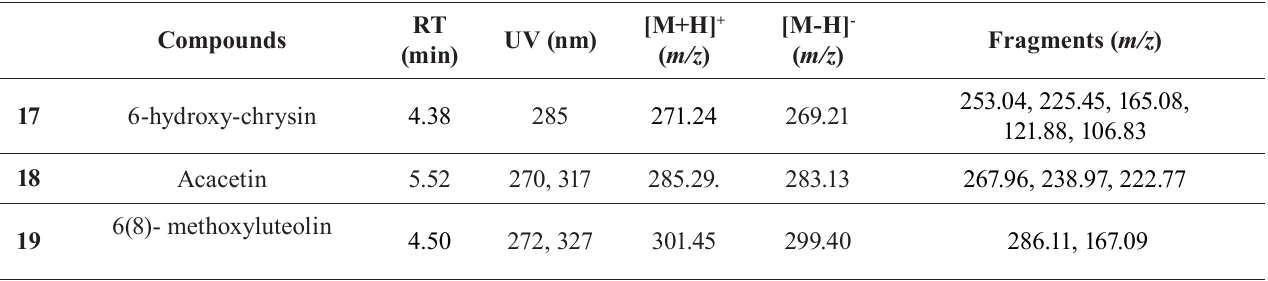
TABLE I - F lavonoids identified in ethanolic extract of leaves from the Fridericia samydoides